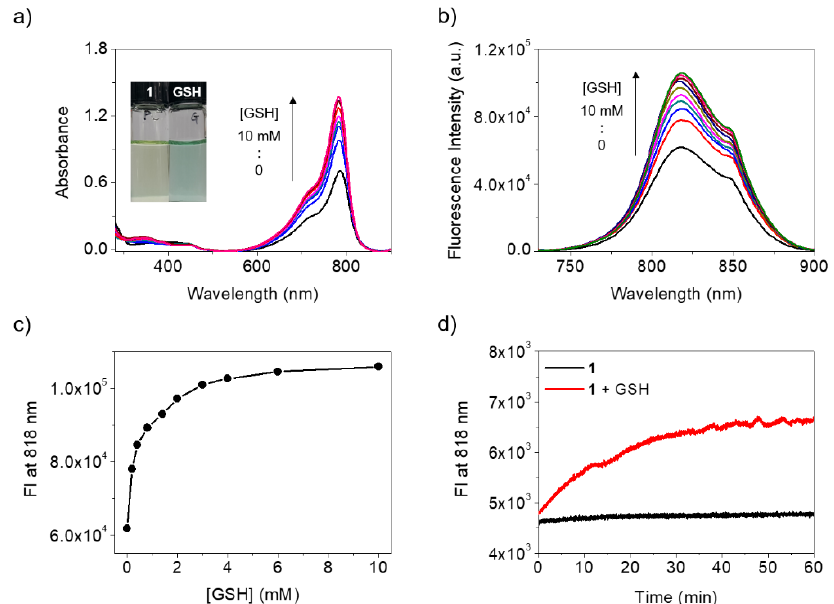
Figure 2. ( a ) UV-Vis absorption and ( b ) fluorescence spectra of 1 (10 µ M) in presence of different concentrations of GSH (0–10 mM); ( c ) plot of fluorescence intensity at 818 nm of 1 vs. [GSH]; ( d ) time-dependent fluorescence change of 1 (10 µ M) to 10 mM of GSH. All data was obtained in HEPES buffer (10 mM, pH 7.4) containing 1% ( v / v ) of DMSO after incubation of 1 h at room temperature. The excitation wavelength was affected at 720 nm.